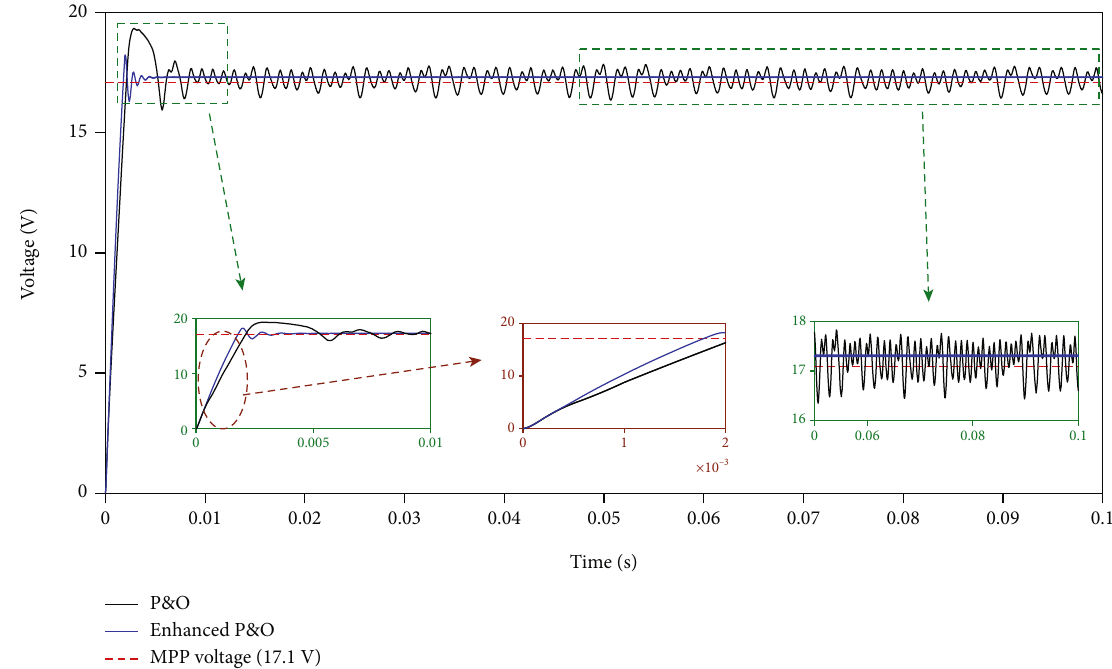
Figure 12: Tracking of MPP voltage with P&O enhanced P&O method under Test 1.